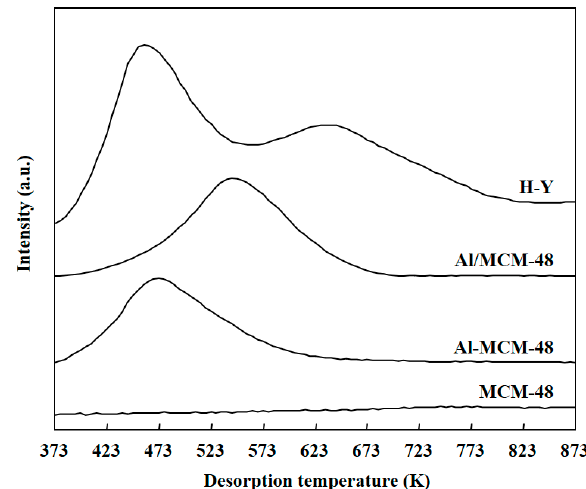
Figure 3. Profiles of ammonia temperature-programmed desorption (NH 3 -TPD) for various solid samples after calcination at 823 K for 4 h.